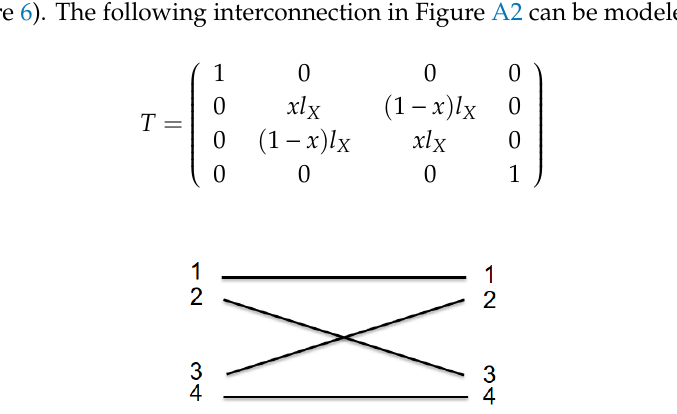
interconnections, S j is a matrix of MZIs in a stage. T j is the interconnection matrix connecting two